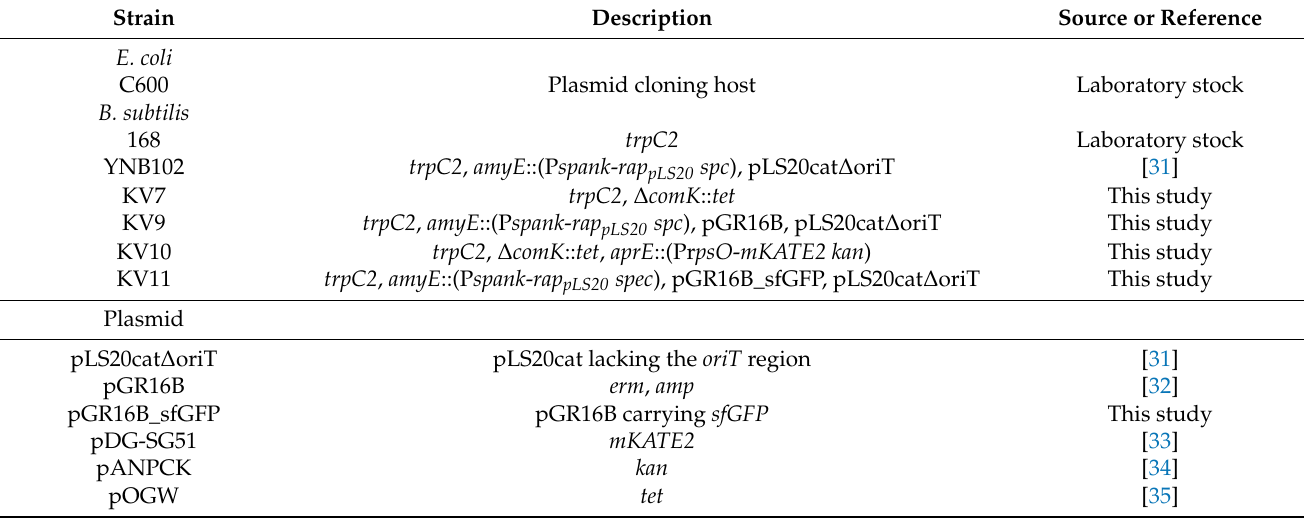
Table 1. Bacterial strains and plasmids used in this